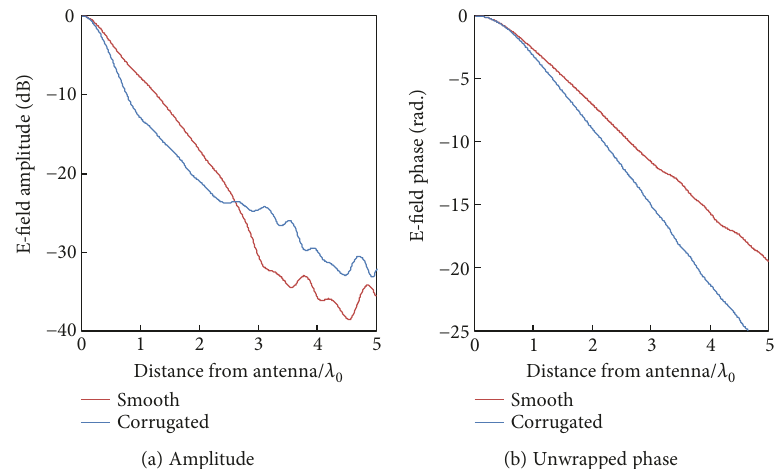
Figure 5: Normalized e- fi eld intensity distribution for fl at and corrugated radomes: (a) amplitude and (b) unwrapped phase.